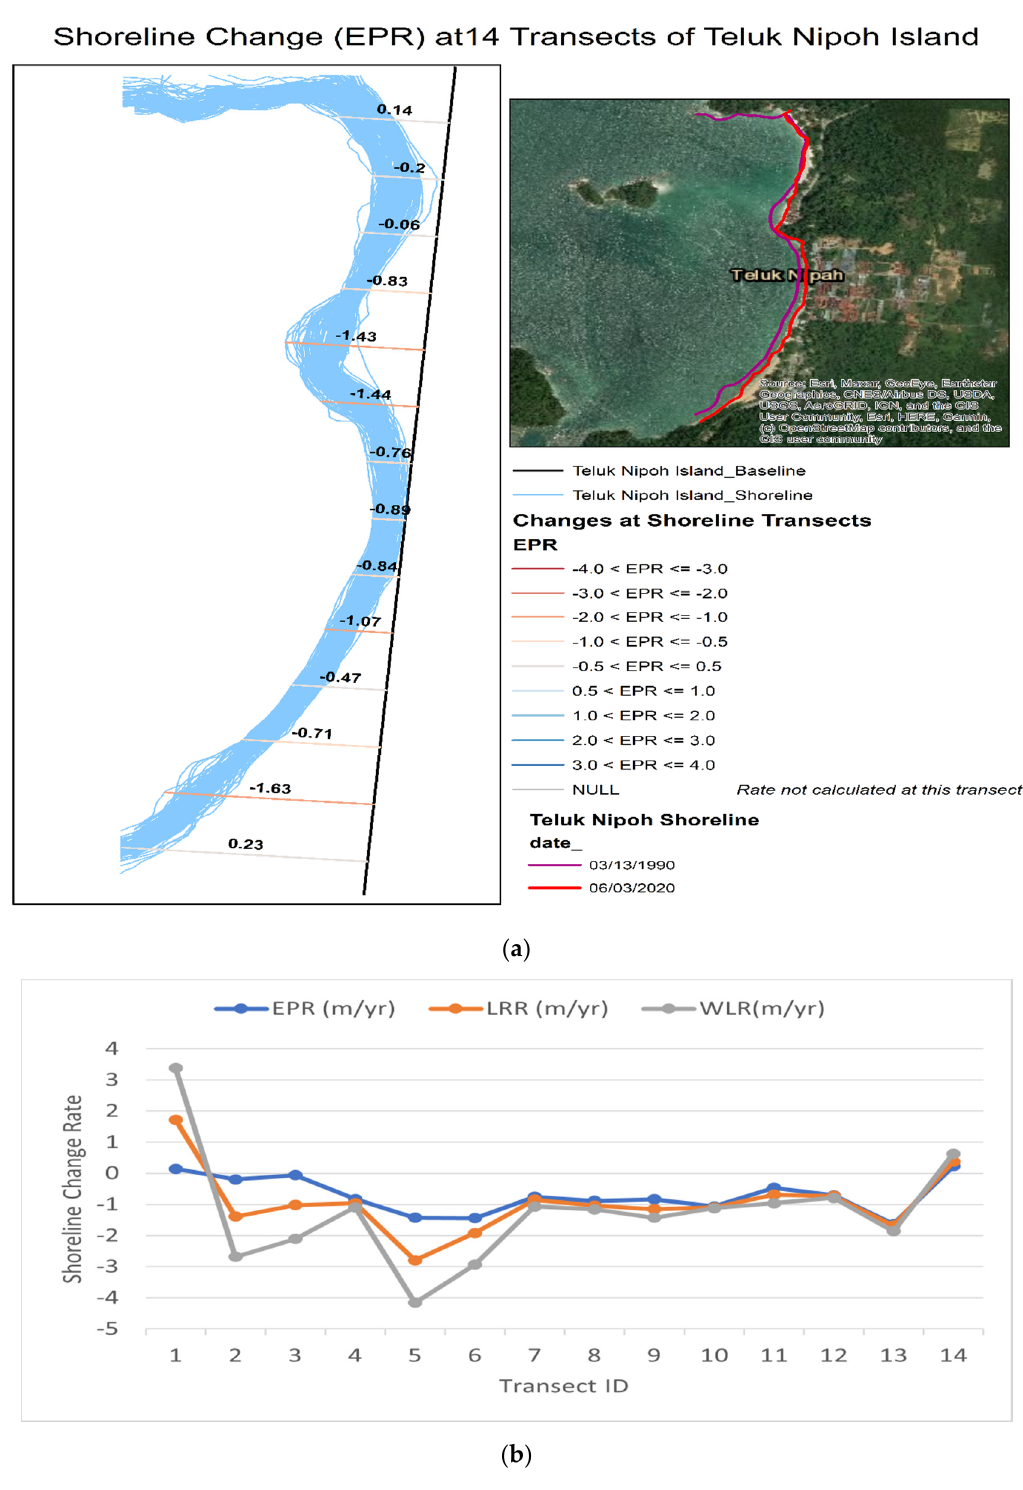
Figure 6. ( a ) Map of shoreline change rate (EPR). ( b ) Plot of shoreline change rate for EPR, LRR, and WLR.